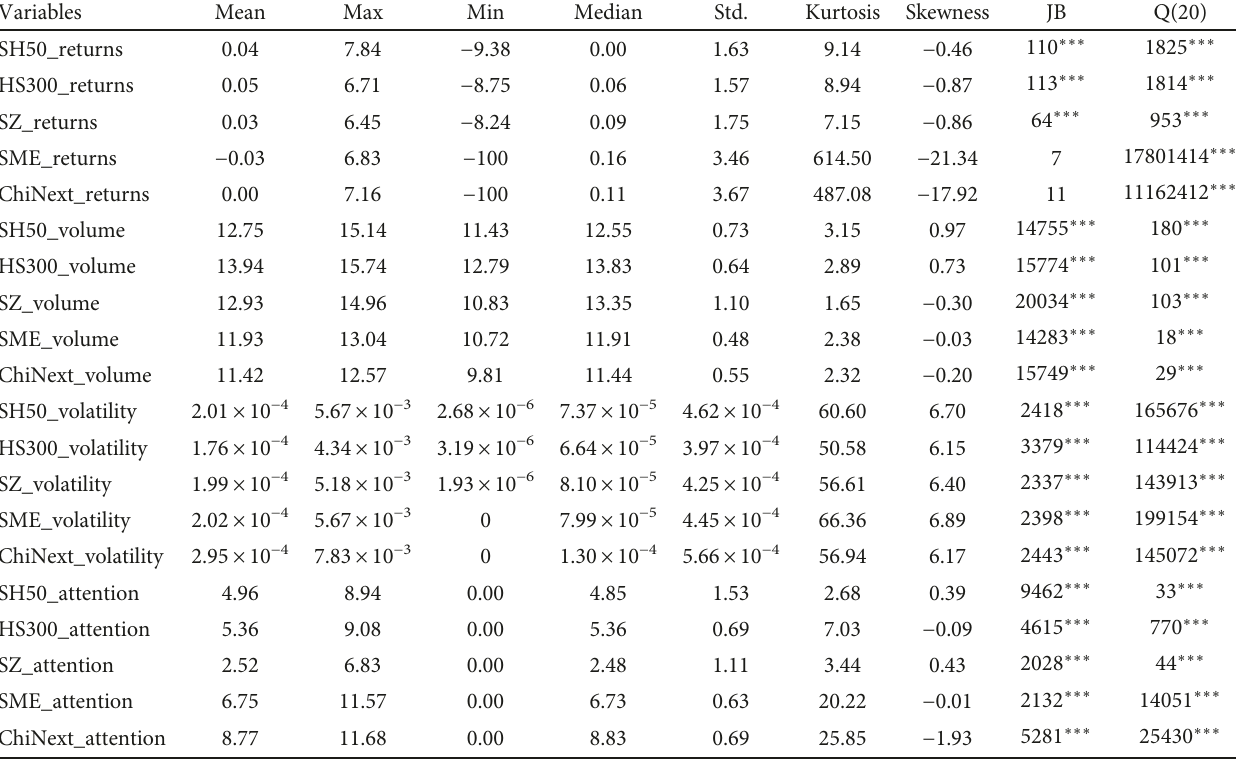
Table 1: Statistical properties for the